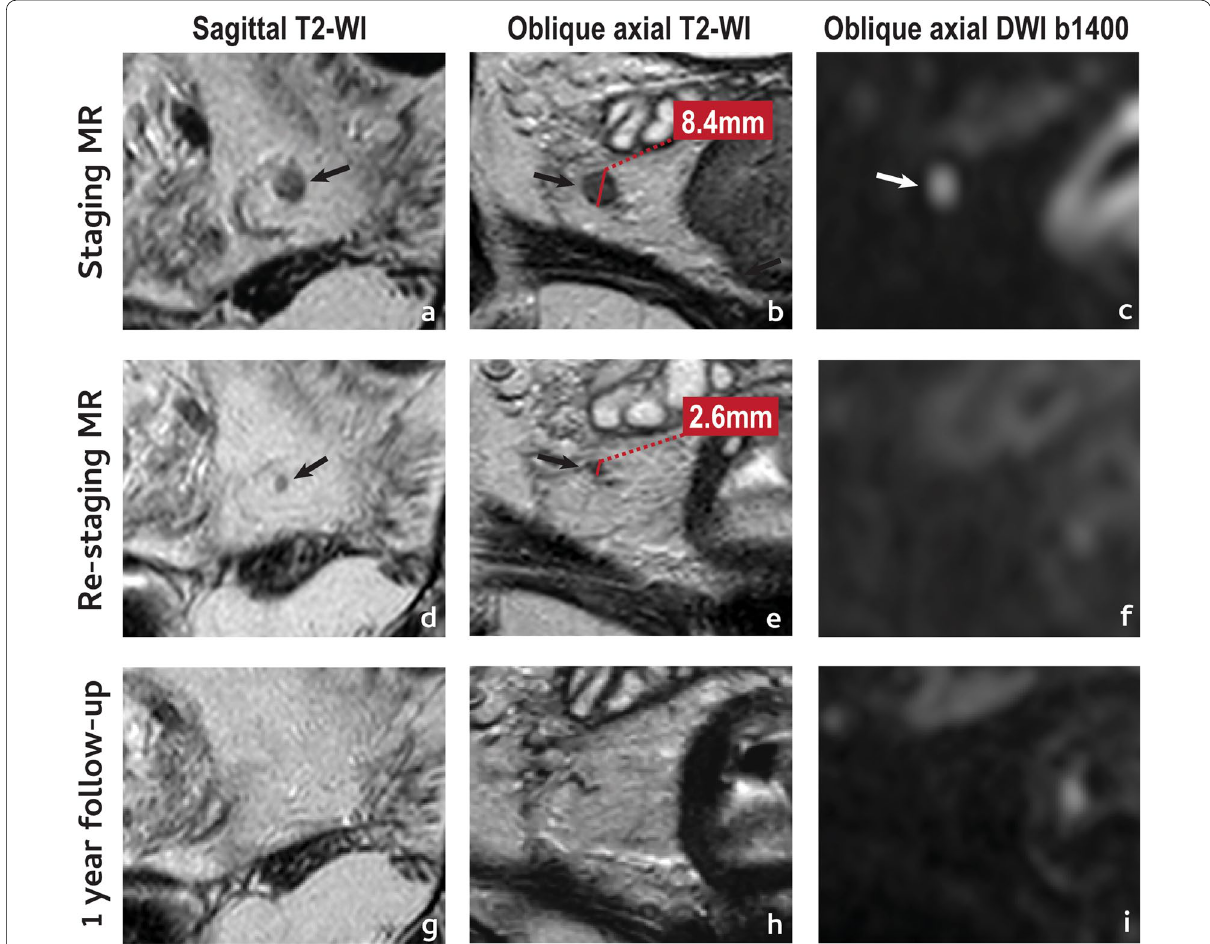
Fig. 7 Complete lymph node response. A 42 year-old male presented with a low mrT3a (not shown) mrN1a (arrow in a – c ) EMVI cancer. He underwent NAT and was re-staged. The positive lymph node showed a pronounced reduction in size after NAT, with a short axis reduction of 70% and a short axis < 5 mm ( e ). On T2-WI, the lymph node became too small to characterise ( e ). The lymph node was not visible on re-staging high b value DWI ( f ) and disappeared also on T2-WI at 1-year follow up MR imaging ( g – i ). Patient is currently under W&W with no clinical signs of viable local or distant